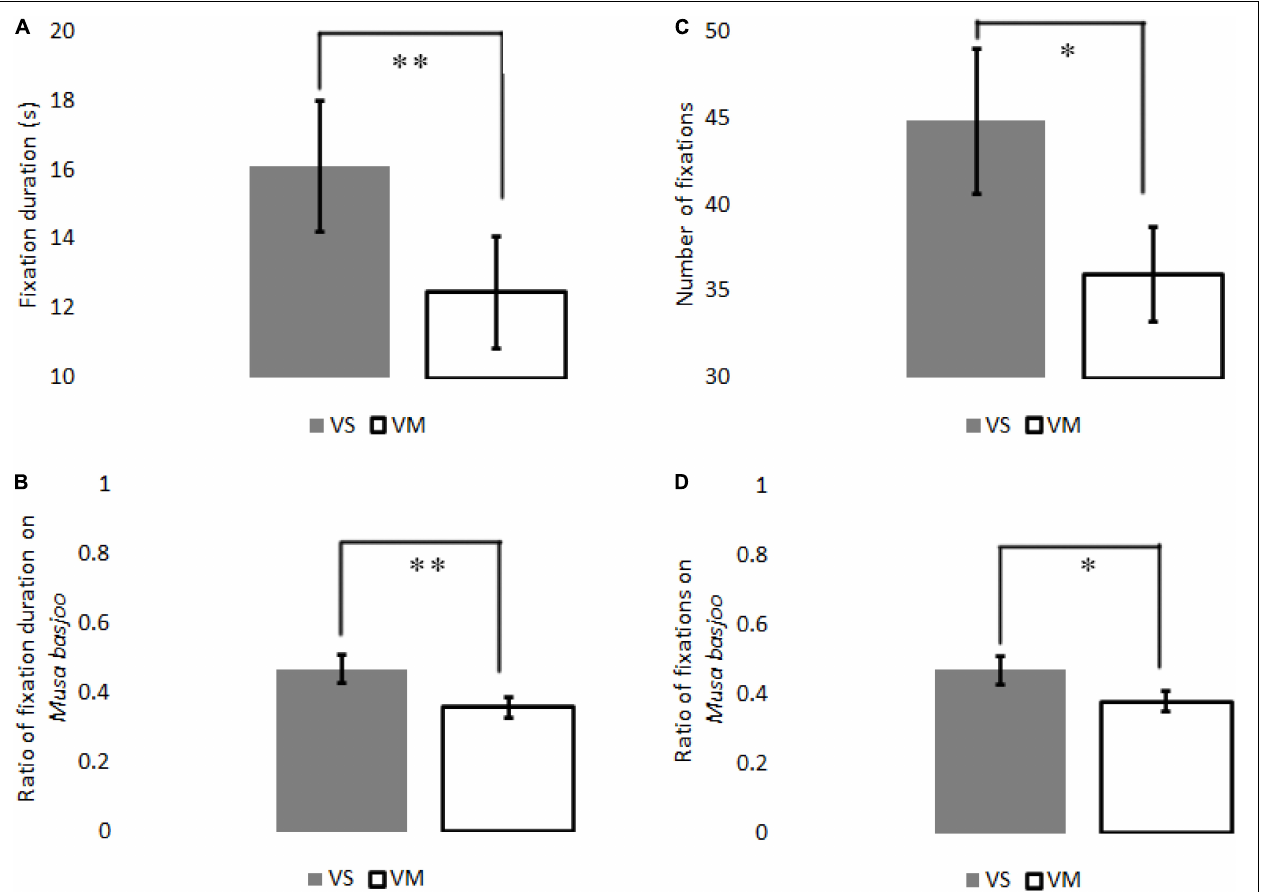
FIGURE 5 | (A) The comparison of fixation duration between the two videos. (B) The comparison of ratio of fixation duration on Musa basjoo between the two videos. (C) The comparison of number of fixations between the two videos. (D) The comparison of ratio of number of fixations on Musa basjoo between the two videos. Data are shown as means ± SEM ( n = 24, ∗ p < 0.05, ∗∗ p < 0.01). VS, video with sound; VM, video